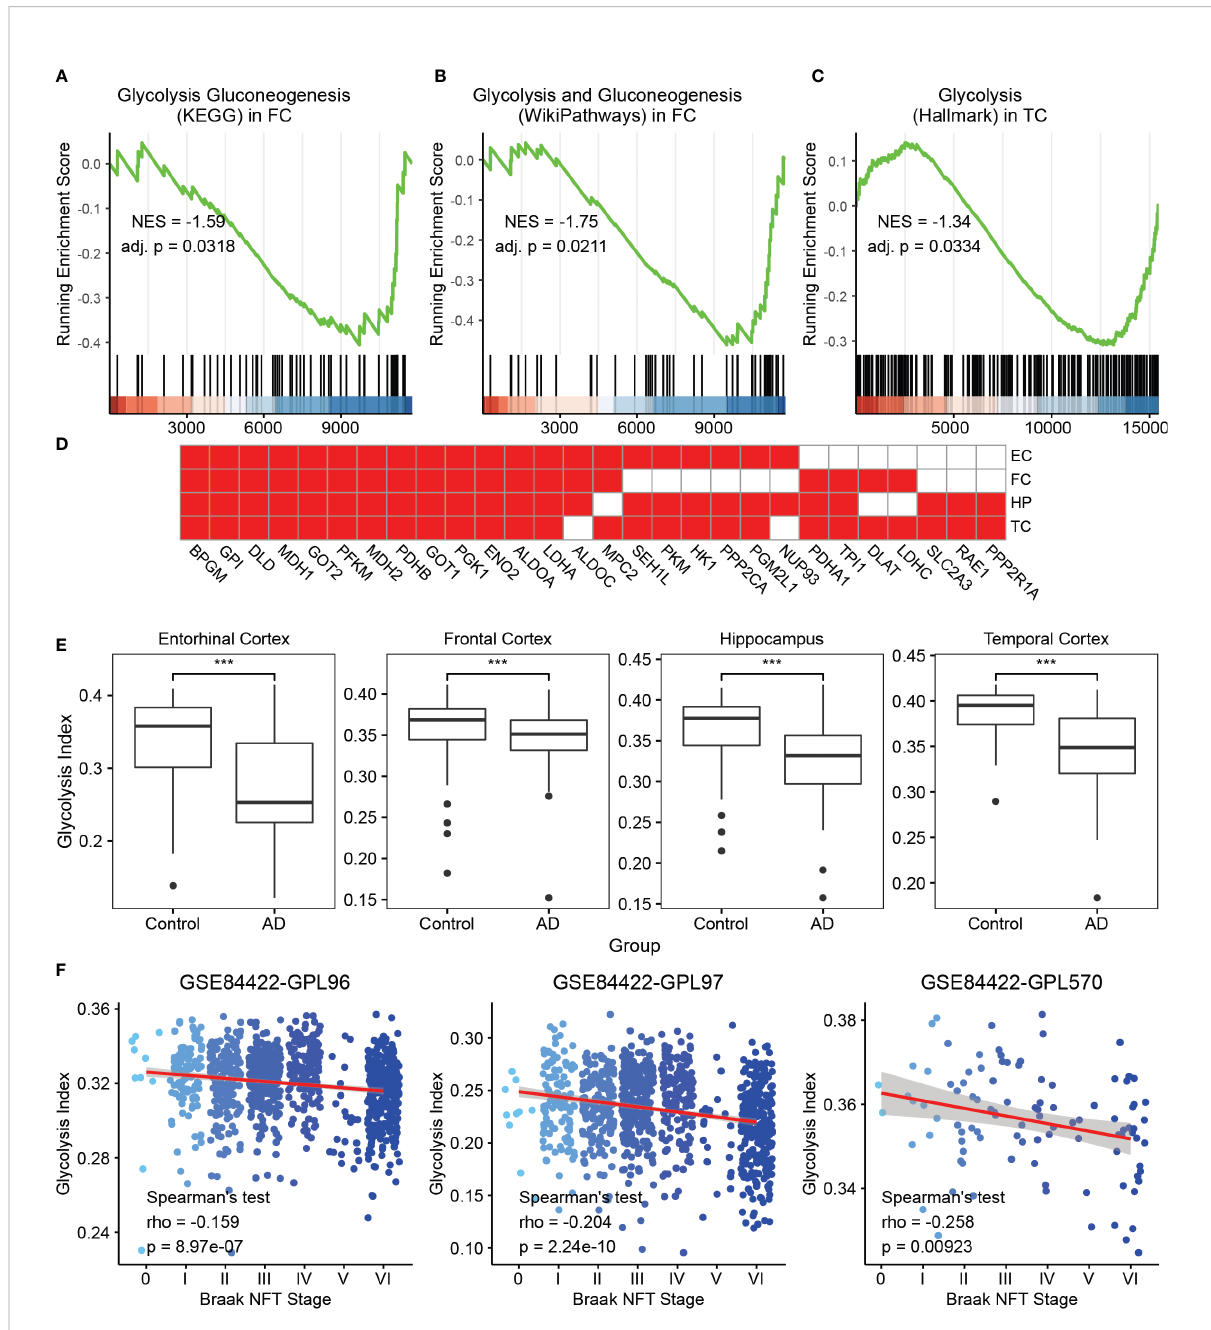
FIGURE 1 Glycolysis index and its clinical relevance in AD (A-C) GSEA analysis on AD vs. control samples of the glycolysis gluconeogenesis (KEGG) gene set in FC. (A) Glycolysis and gluconeogenesis (Wikipathways) in FC and (B) glycolysis (Hallmark) in TC (C) The green curve denotes the running ES for the gene set as the analysis moves down the ranked list of genes. Positive correlation, NES >0; Negative correlation, NES <0. Adj. P, adjusted p-value. These callouts also apply to the Supplementary Figure 1. (D) The 28 core glycolysis genes. Cells in red denote the genes identi fi ed as leading edge genes in these brain regions. (E) AD samples reveal lower glycolysis indices than that in the control in different brain regions. ***p<0.001. (F) The trends of glycolysis index in different Braak NFT stages using the GSE84422 dataset. Blue dots represent the individual samples. NES, Normalized enrichment score; GSEA, gene set enrichment analysis; AD, Alzheimer ’ s disease; FC, frontal cortex; TC, temporal cortex; ES, enrichment score; NFT, neuro fi brillary tangles; and KEGG, Kyoto Encyclopedia of Genes and